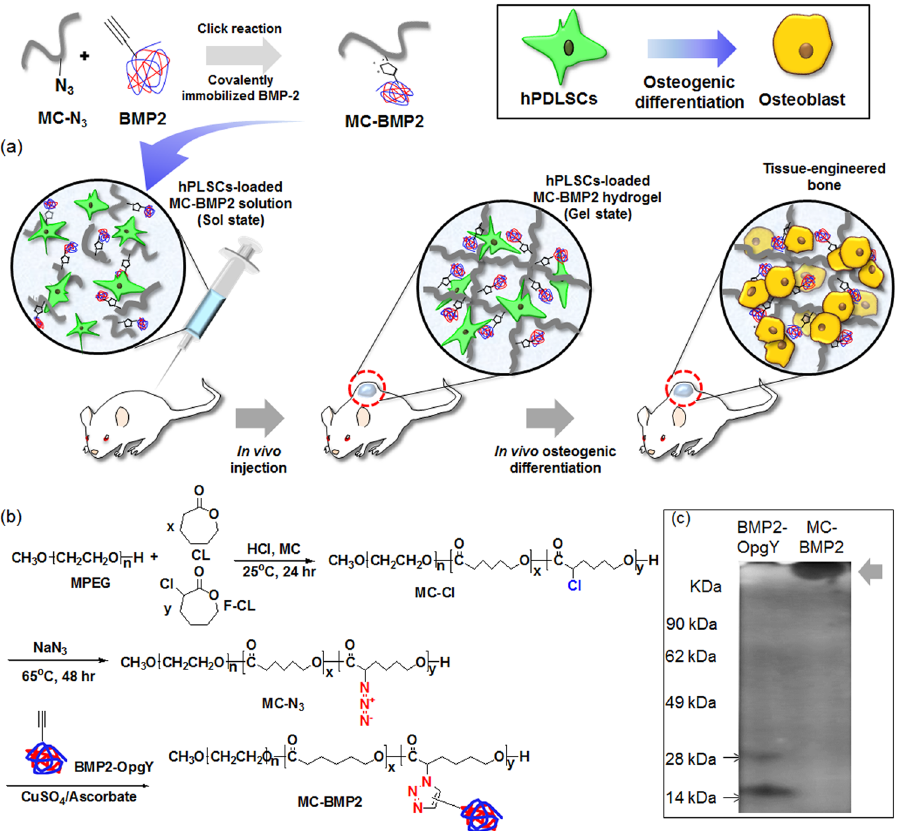
Figure 1. ( a ) Schematic of osteogenic differentiation of human periodontal ligament stem cells in an in vivo - formed MC-BMP2 hydrogel, ( b ) synthesis of MC-Cl, MC-N 3 , and MC-BMP2 and ( c ) sodium dodecyl sulfate- polyacrylamide gel electrophoresis of BMP2-OpgY and MC-BMP2. Sulfate-polyacrylamide gel was cropped and full-length gel included in Supplementary Fig.